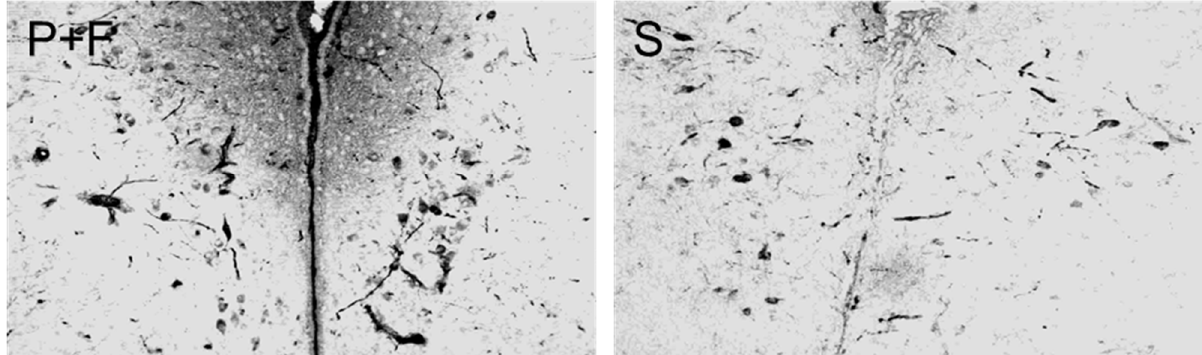
Figure A2. Arginine-vasopressin immunoreactivity in the paraventricular nuclei of Syrian hamsters. Comparison between sexual stimulation with pheromone and females (P+F, group 1) and sleep (S, group 5). Magnification: 50×.